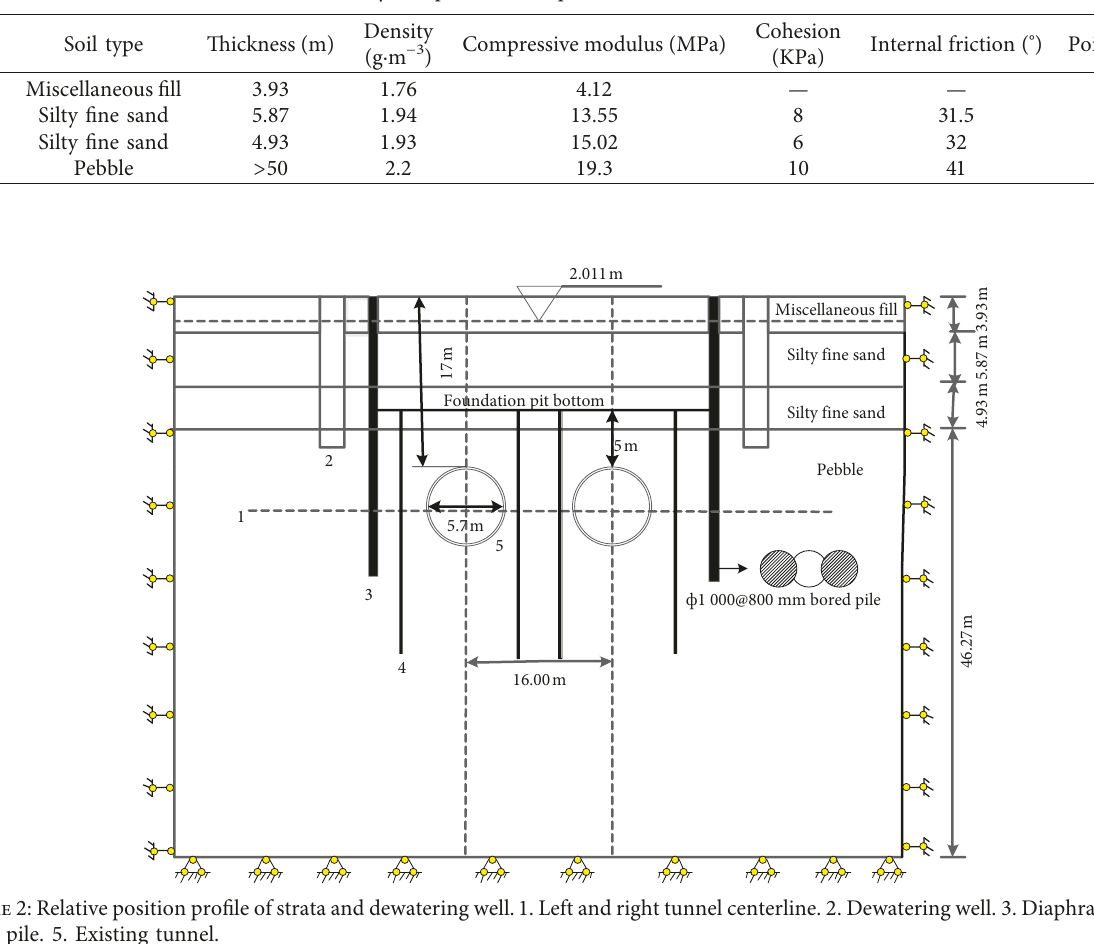
Table 1: Physical performance parameters of rock and soil